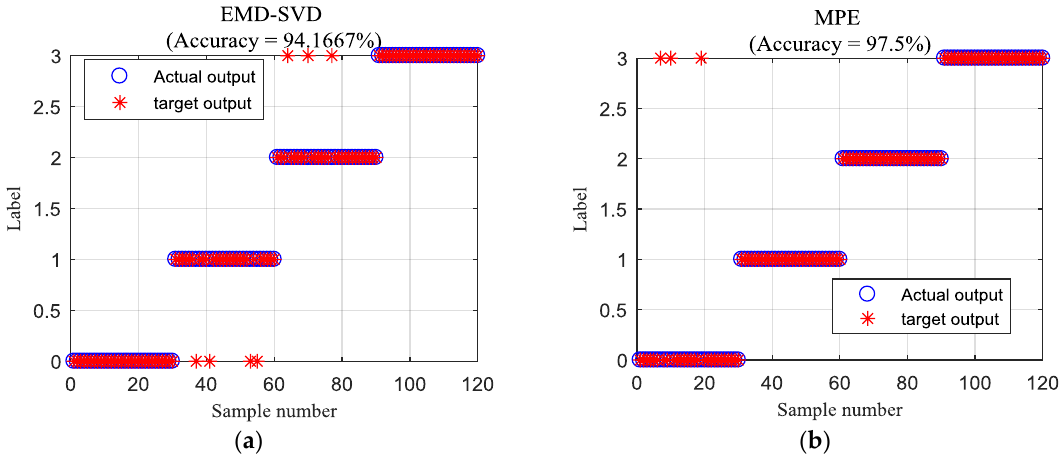
Figure 18. The recognition results of: ( a ) empirical mode decomposition-singular value decomposition (EMD-SVD); ( b ) multi-scale permutation entropy (MPE).